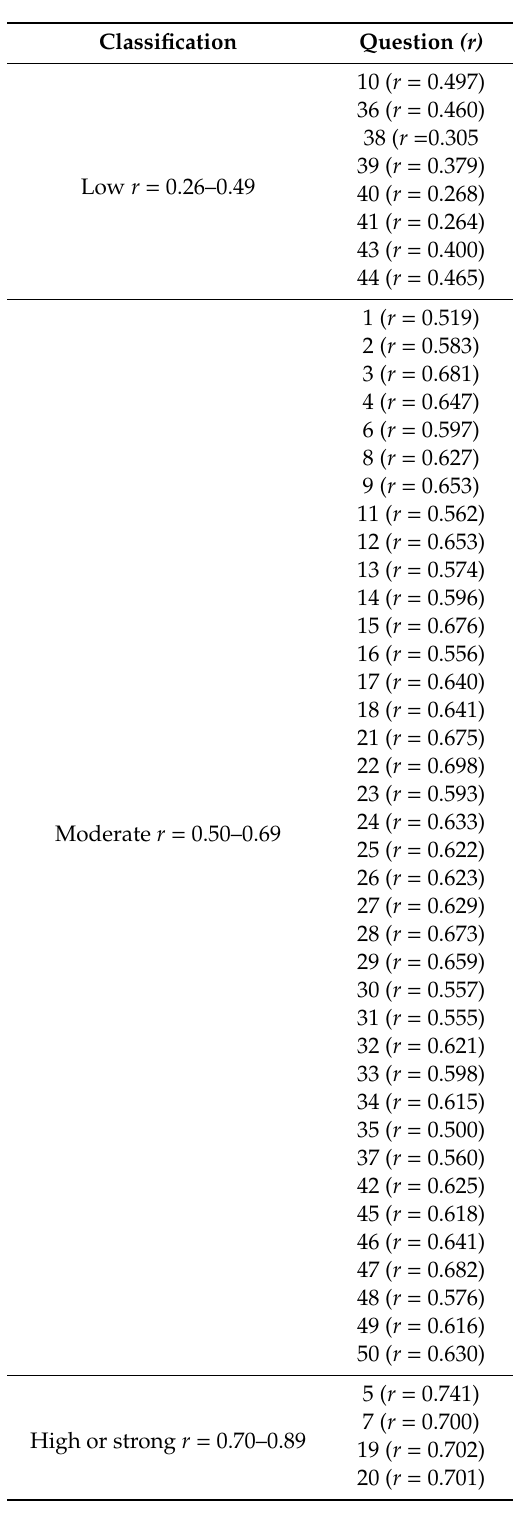
Table 5. Classification of Pearson’s